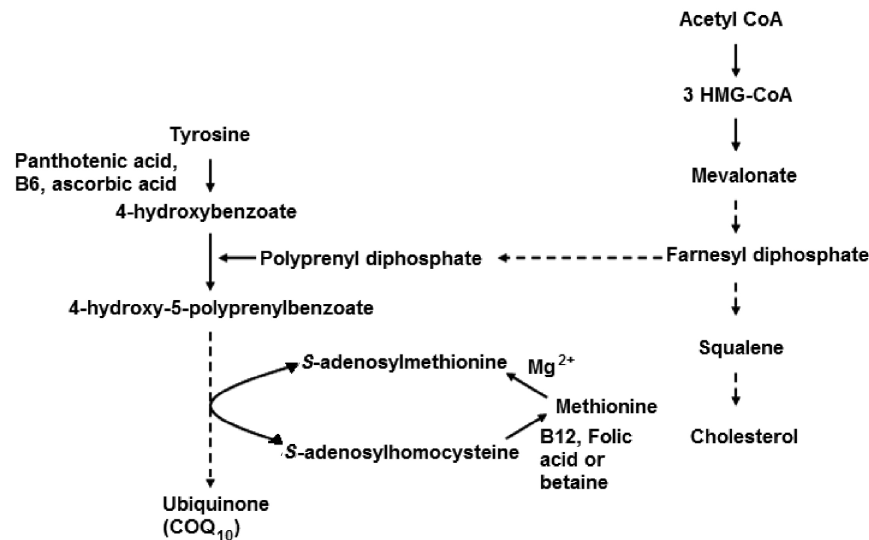
FIGURE 1 - Structure of coenzyme Q methyl-6-decaprenil-1,4-benzoquinone). Source: Shinde, Patil, Tendokar, 2005.